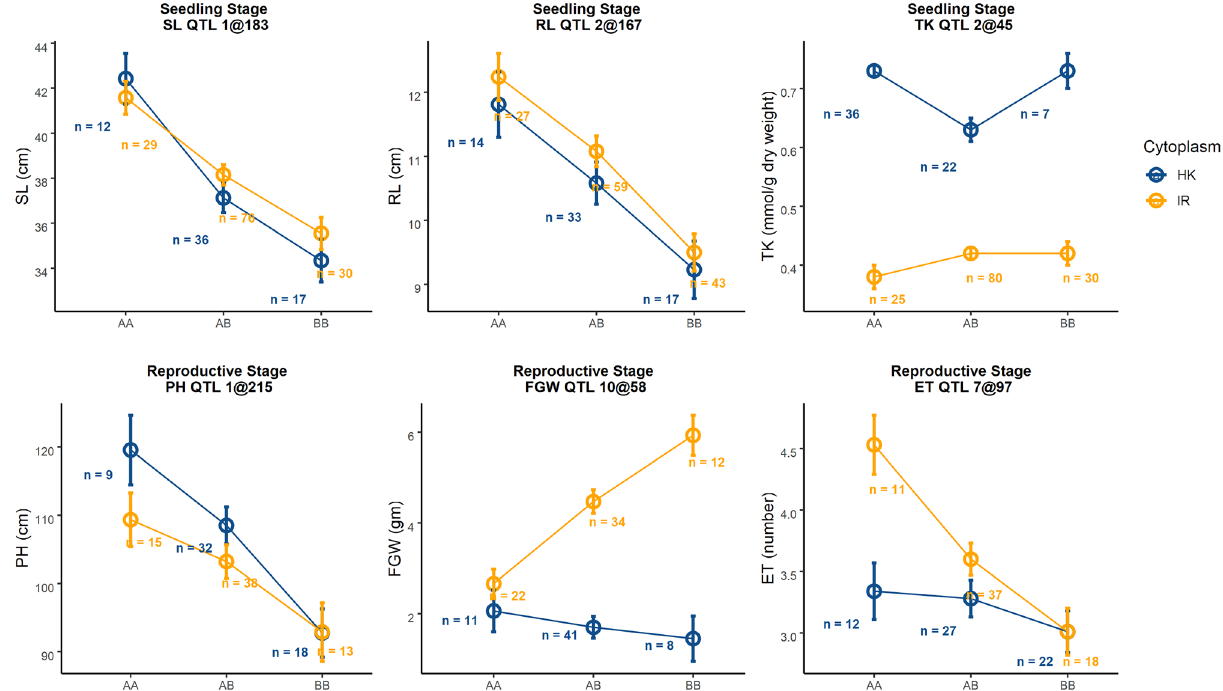
Figure 4. Interaction plots of allelic effect of QTL and cytoplasm on different traits from two different treatment stages. Blue line shows plants with Horkuch cytoplasm whereas orange line indicates plants with IR29 cytoplasm. Alleles are plotted on x-axis where AA, AB and BB indicate homozygous Horkuch , heterozygous of Horkuch / IR29 and homozygous IR29 respectively. Allelic means ± SE are reported. Representative QTL effects for SL and PH are presented in the upper panel and exhibit no significant interaction with cytoplasm. The third plot from the left on upper panel demonstrates significant additive effects of the maternal cytoplasm on TK. In the bottom panel, plot two and three from the left demonstrate significant interaction of QTL alleles with cytoplasm for traits such FGW,